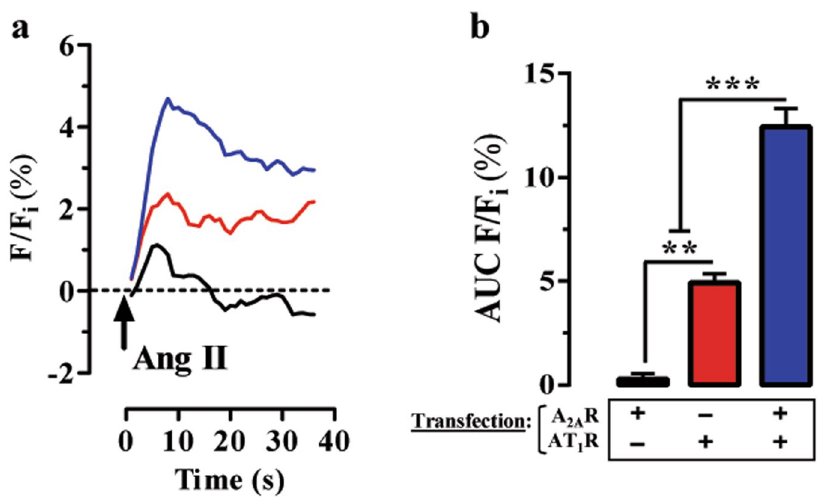
Figure 3. A 2A R expression potentiates AT 1 R functioning. ( a ) Representative Angiotensin II-mediated intracellular Ca 2 + accumulation determined by Fluo4 assay. HEK-293T cells were transiently transfected with A 2A R (black trace), AT 1 R (red trace) and A 2A R + AT 1 R (blue trace). Cells were loaded with Fluo4-NW dye and challenged with Angiotensin II (50nM). The [Ca 2 + ] i dynamics is shown as change in fluorescence of the Fluo4 signal (F) expressed as percentage of the maximal Ca 2 + influx elicited by ionomycin (F i ) in each experimental conditions. ( b ) Quantification of the AT 1 R-mediated [Ca 2 + ] i accumulation measured by Fluo4. The integrated area under the curve (AUC) of the normalized AT 1 R-mediated Fluo4 signal (F) is expressed as percentage of the corresponding ionomycin signal (Fi) for each transfection. The data are expressed as the mean ± SEM of three independent experiments performed in triplicate. The asterisk indicates statistically significant differences ( ** P < 0.01, *** P < 0.001; 1-way ANOVA with a Newman-Keuls post-hoc